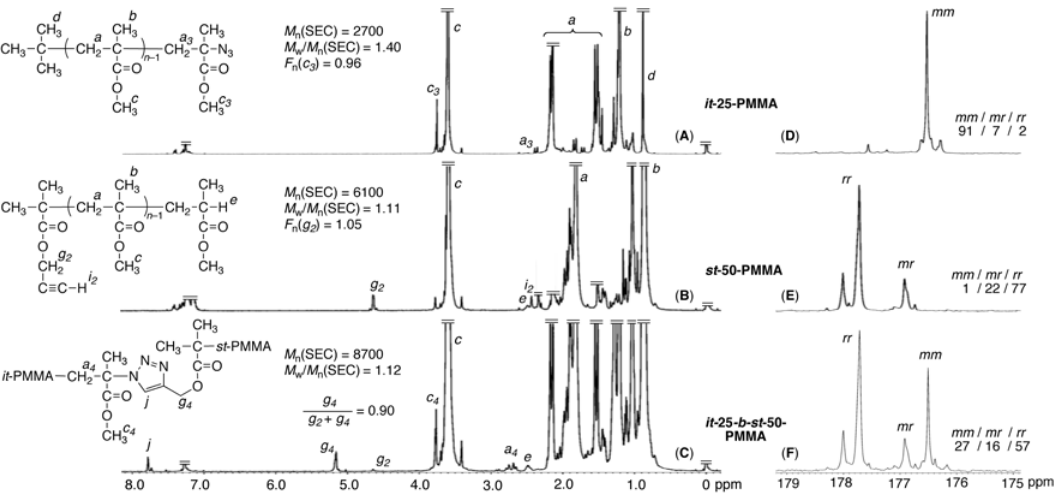
Figure 6. 1 H and 13 C NMR spectra (in CDCl 3 at 55 °C) of it -25-, st -50-, and it -25- b - st -50-PMMAs: ( A , D ) it -25-PMMA-N 3 obtained in isotactic anionic polymerization of MMA followed by chlorination and azidation; ( B , E ) st -50-PMMA-C≡CH obtained in syndiotactic anionic polymerization of MMA followed by deprotection of Me 3 Si-group; ( C , F ) it -25- b - st -50-PMMA obtained via CuAAC between it -25-PMMA-N 3 and st -50-PMMA-C ≡ CH in the presence of CuSO 4 /sodium ascorbate in DMSO/H 2 O